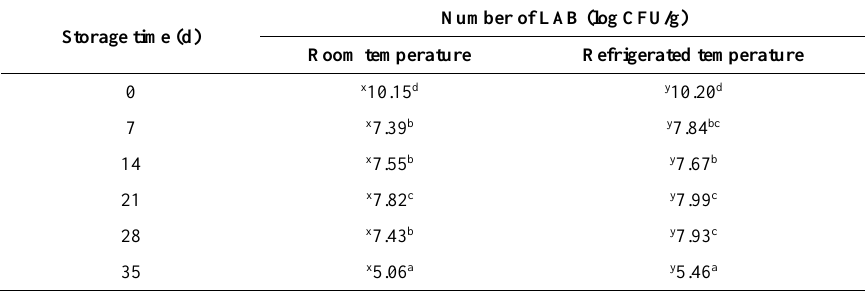
Table 4. Viability of strain B1295 microencapsulated with CMFH from OPT at different temperatures for 35 days storage Number of LAB (log CFU/g) Storage time (d) Room